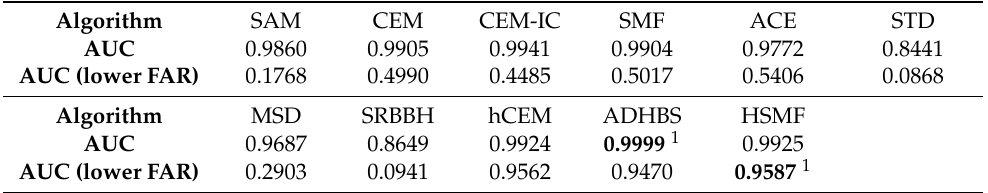
Table 1. Area under the receiver operating characteristic (ROC) curves (AUC) values and AUC values at lower false alarm rate (FAR) of all detectors for the San Diego Airport data.